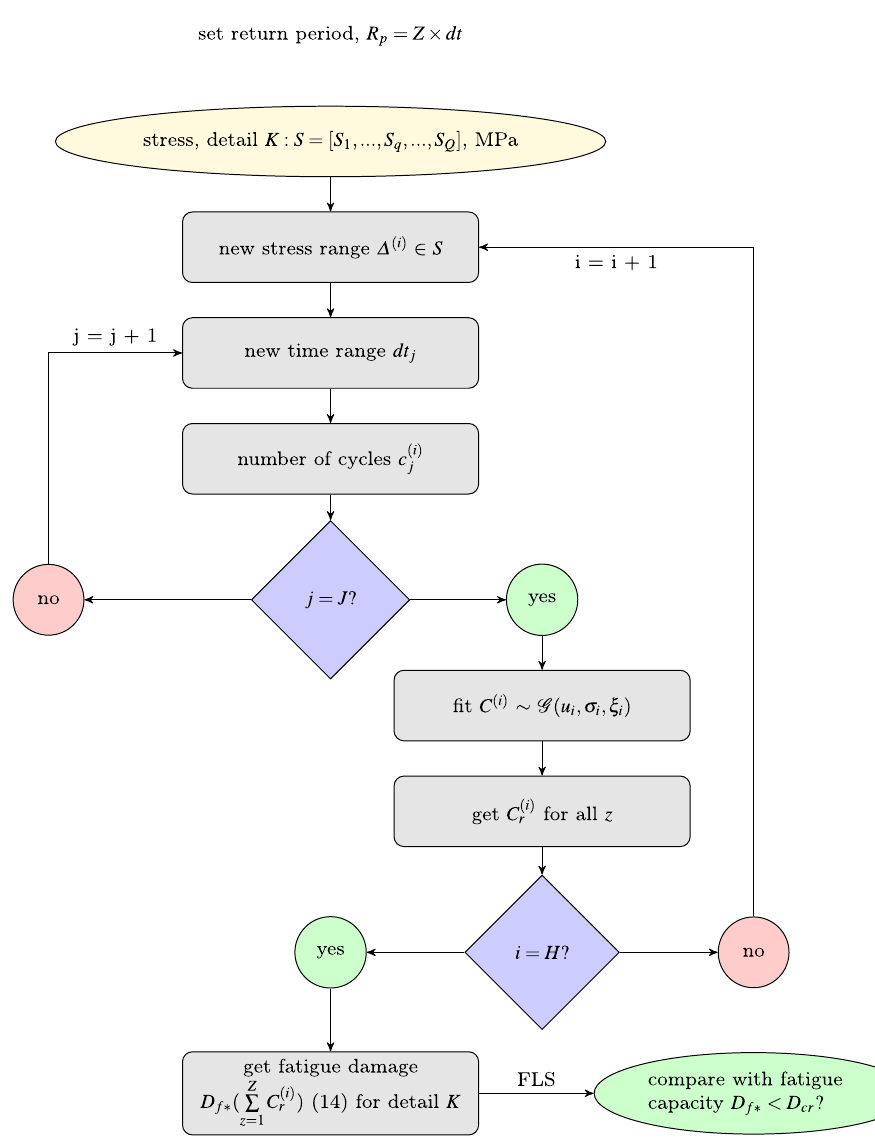
Fig. 9 Proposed algorithm for the use of POT for the